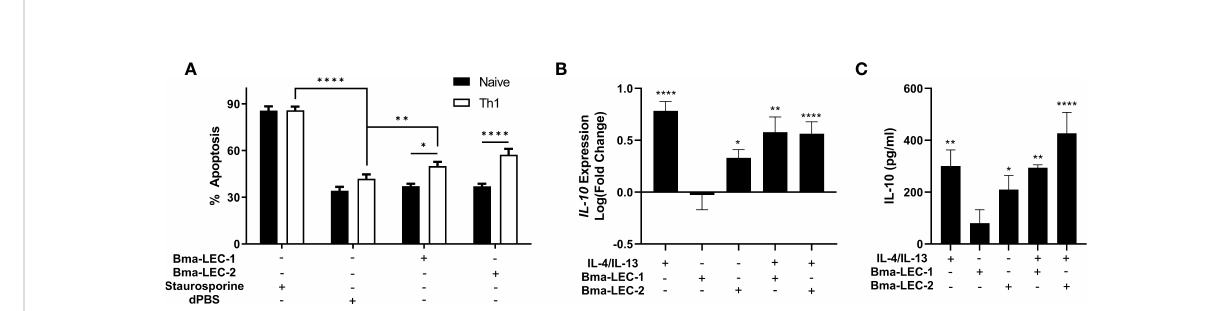
FIGURE 6 rBma-LEC-2 induces suppressive phenotypes in lymphoid and myeloid cells. (A) rBma-LEC-2, but not rBma-LEC-1, is a bioactive effector molecule that selectively induces apoptosis in Th1 cells, but not naïve T cells and (B) promotes polarization of macrophages to an alternatively activated phenotype as indicated by its increase in expression and (C) production of IL-10. These phenotypes are consistent with phenotypes induced by mammalian galectin-9. There is no synergistic effect in either inducing apoptosis of T cells or promoting polarization of macrophages when cells are treated with both human cytokines IL-4 and IL-13 and parasite-derived galectin. N = 3 (minimum) biologically distinct replicates. Mean ± SEM, *P < 0.05, **P < 0.01, ****P <